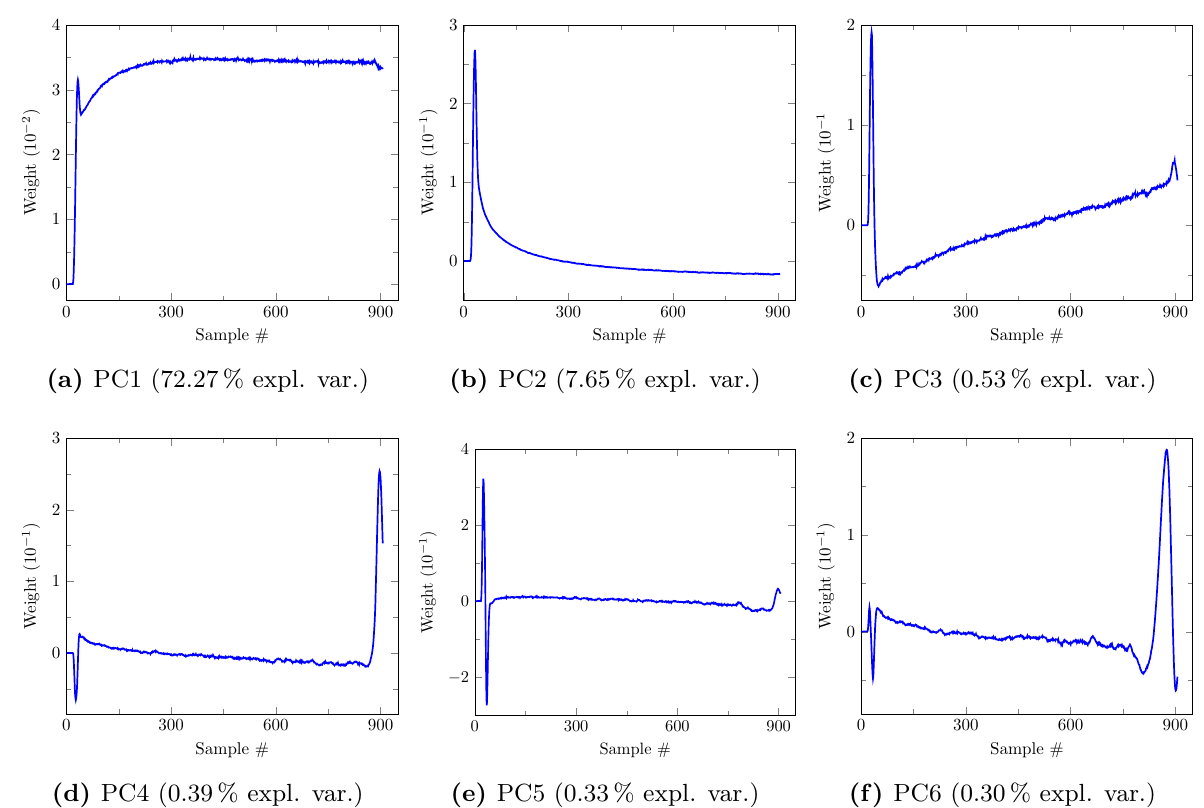
Figure 6. First 6 principal components (PCs) with their explained variance ratio determined on the real model-building dataset (20 patients, 3,974,466 TACs). Each component assigns a weight to each of the 906 TAC samples, starting from 10 s to 1820 s with step 2